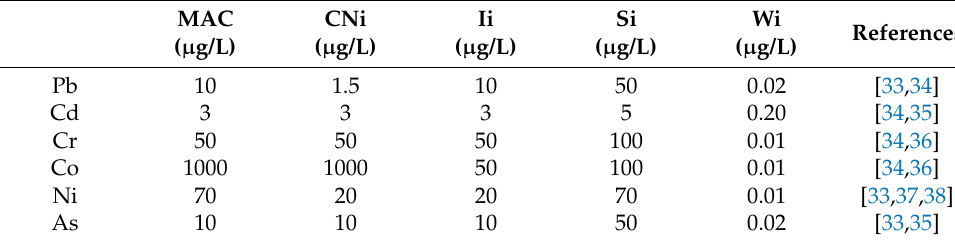
Table 2. Several standard values used to calculate different indices of